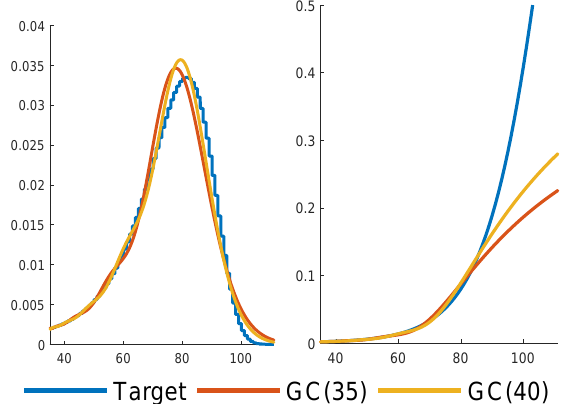
Figure 4. Probability density functions and hazard rate functions for the life table and phase-type fits using the generalized Coxian structures with p = 35,40